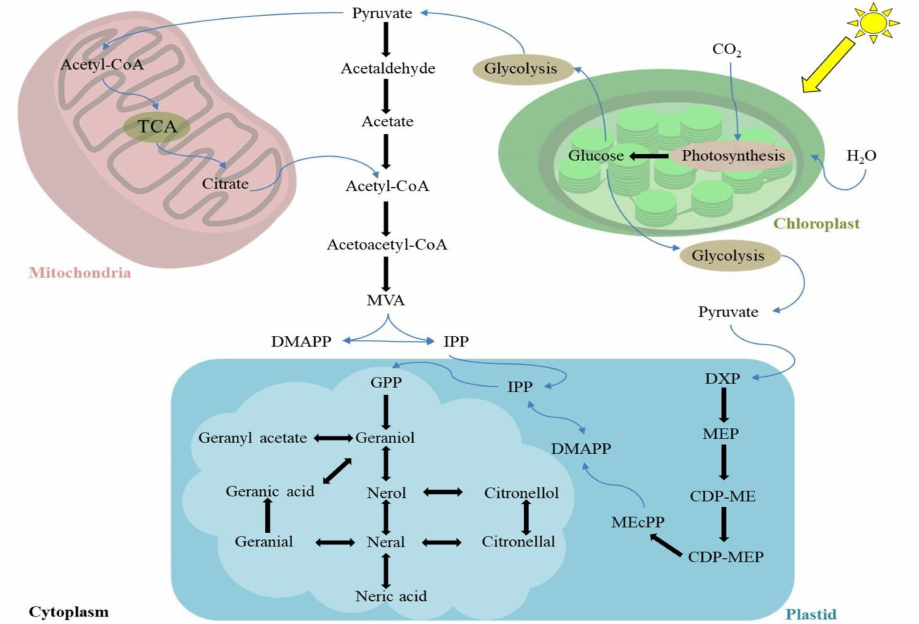
Figure 2. A mechanistic model for the biosynthesis of lemongrass essential oil and its crosstalk with other metabolic processes. Different cellular organelles work in tandem for oil production in lemongrass leaves. The lemongrass chloroplast, like most of the other plants, produces glucose through photosynthesis. The glucose undergoes glycolysis in the cytoplasm and yields pyruvate, a two-carbon compound. Lemongrass uses pyruvate as a substrate for the biosynthesis of isopentenyl diphosphate (IPP) units, either through the cytoplasmic mevalonate (MVA) pathway or plastidic methylerythritol phosphate (MEP) pathway in their young and rapidly growing leaves. Alternatively, mitochondria can import pyruvate and yield citrate through the tricarboxylic acid (TCA) cycle. The citrate can transform into Acetyl-CoA and join the MVA pathway to yield IPP units. The IPP produced through both pathways is converted into geraniol mediated by geranyl diphosphate (GPP) in lemongrass plastids. The geraniol is considered as a precursor for essential oil biosynthesis in lemongrass and yields all the major components through multiple reversible and irreversible reactions. The plastidic bubble highlights these reactions along with their substrates. DMAPP,